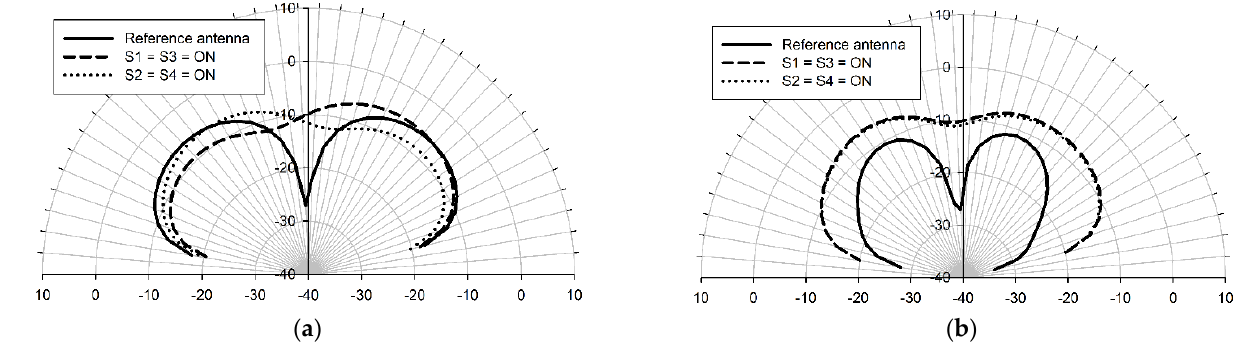
Figure 9. Reflection coefficient versus frequency when S2 = S4 = ON and S1 = S3 = ON. The simula- tions were done with the Sonnet Professional software.